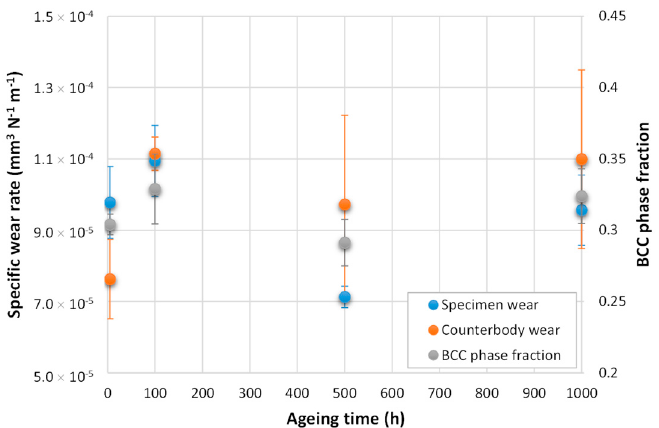
Figure 10. The specific wear rate of specimens and counter-body, and BCC (B2) phase fraction of as-cast AlCoCrFeNi 2.1 and after aging at 800 ◦ C at three di ff erent durations.